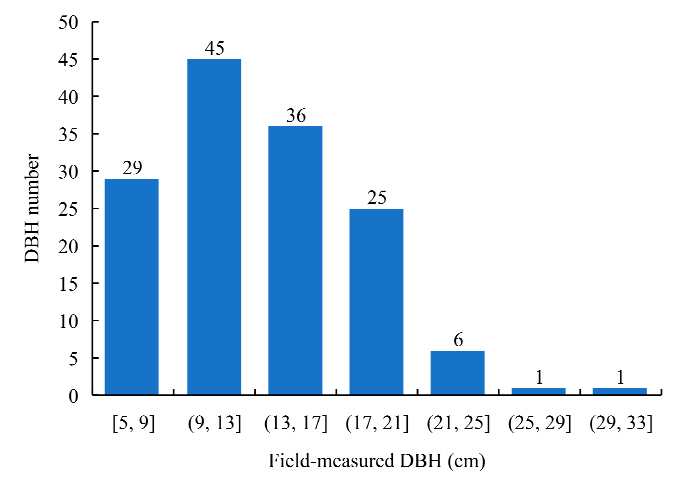
Figure 3. The histogram of field-measured DBH values.